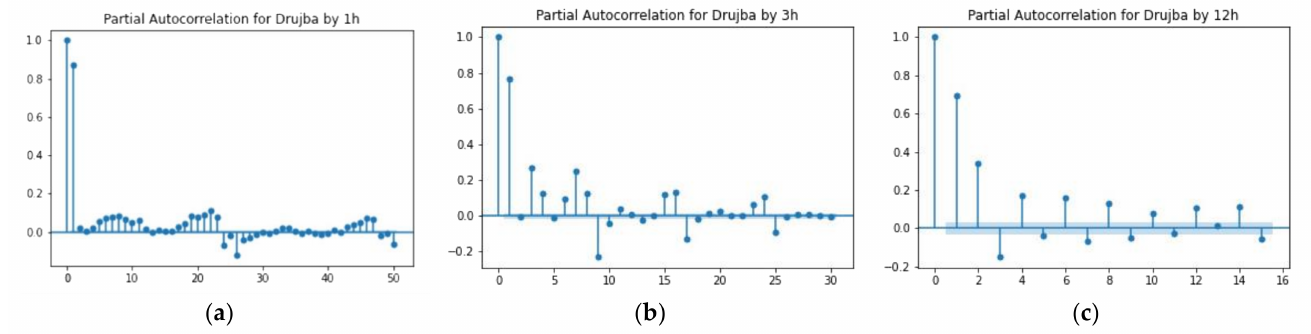
Figure 8. Partial autocorrelation of NO 2 in “Drujba” air quality station measured at 1 h granularity ( a ), 3 h granularity ( b ) and 12 h granularity ( c